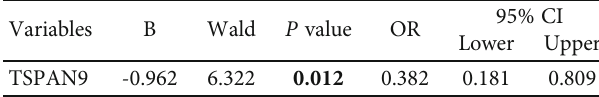
Table 2: Association between the expression of TSPAN9 and clinicopathological features of HCC